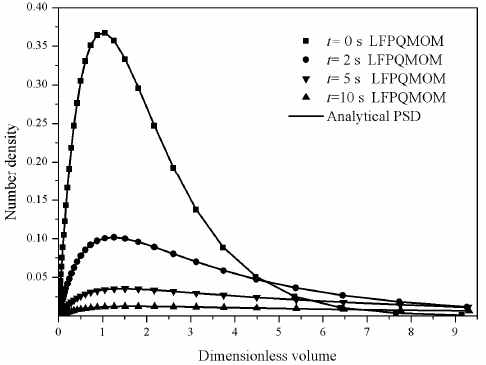
Figure 6. Particle size distributions at 0, 2, 5, and 10 s (square: numerical PSD at 0 s; circle: numerical PSD at 2 s; down triangle: numerical PSD at 5 s; up triangle: numerical PSD at 10 s; line: analytical PSD).